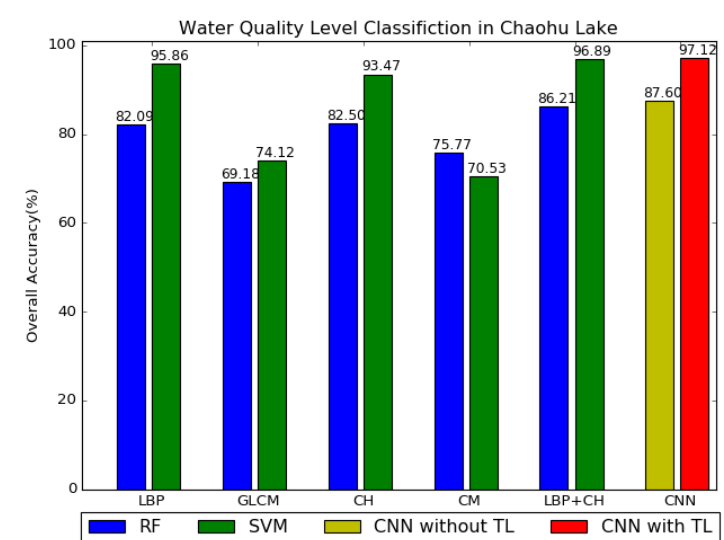
Figure 7. Comparisions of water-quality classification performance in Chaohu Lake.